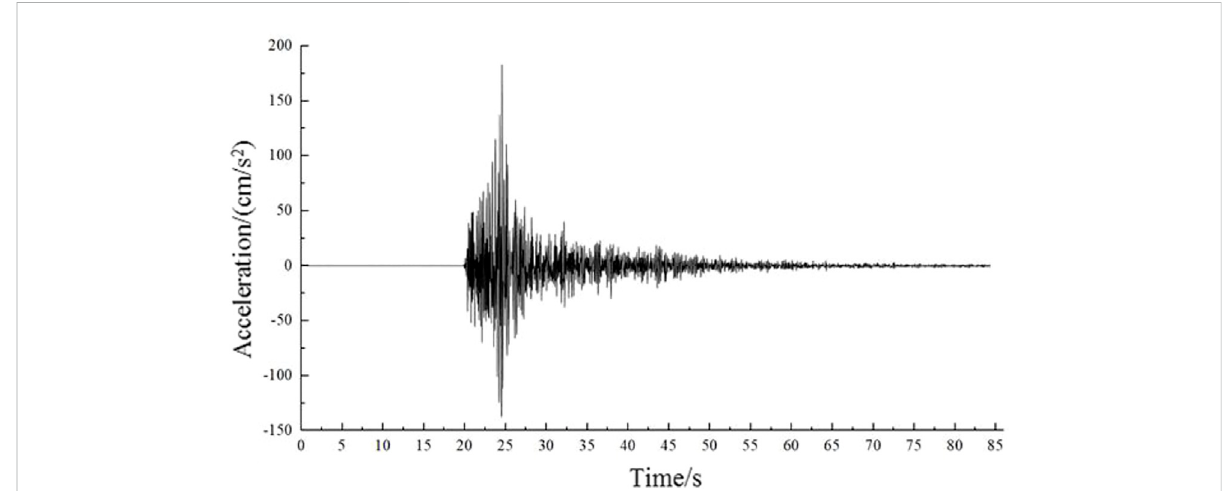
FIGURE 5 Seismic waveform of the horizontal component of the Minxian seismic wave.